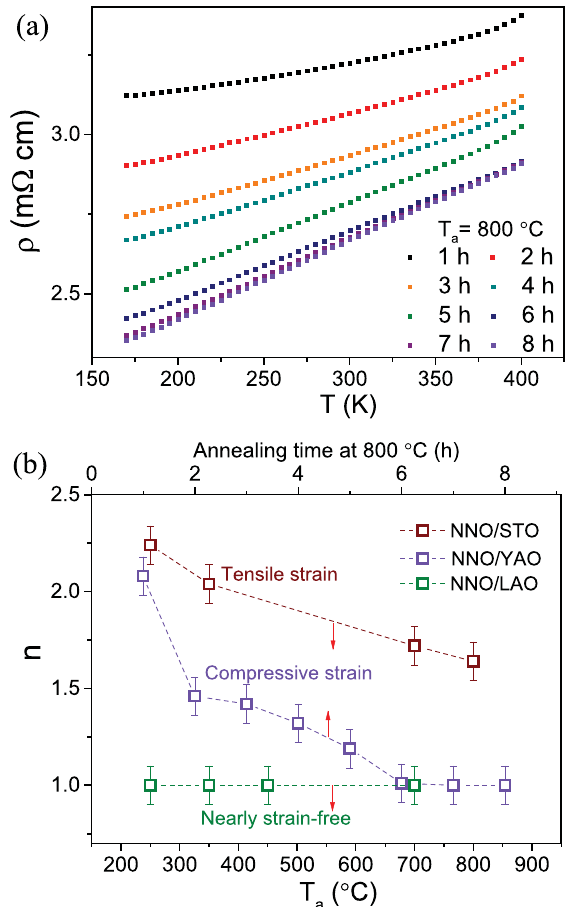
Fig. 2 Tunable resistivity scaling by regulating disorder. a Resistivity of NNO/YAO fi lm as a function of temperature after annealing in an oxygen-enriched environment at 800 °C with various annealing times. b Evolution of exponents n with the annealing process in 20 nm NNO fi lms grown on three different substrates. Data of NNO/LAO and NNO/STO were extracted from previous work 37 . In b , error bars are obtained from the fi tted model described in the main